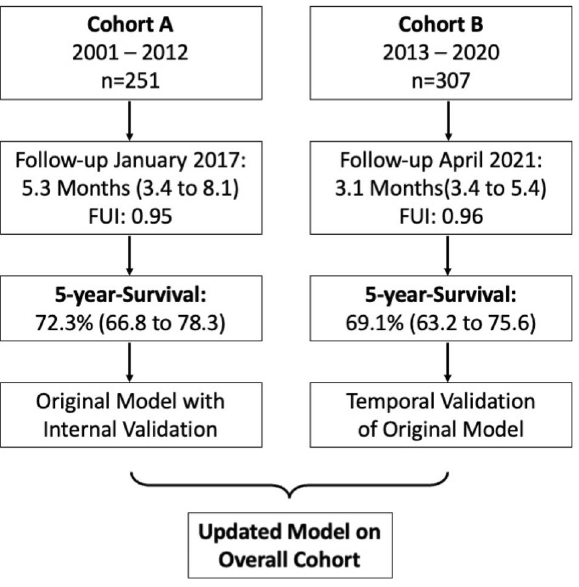
Figure 1. Study Cohort. Follow-up period is reported by median and quartiles (Q1–Q3). 5 years-Survival is reported with median and 95% confidence intervals. FUI = Follow-up